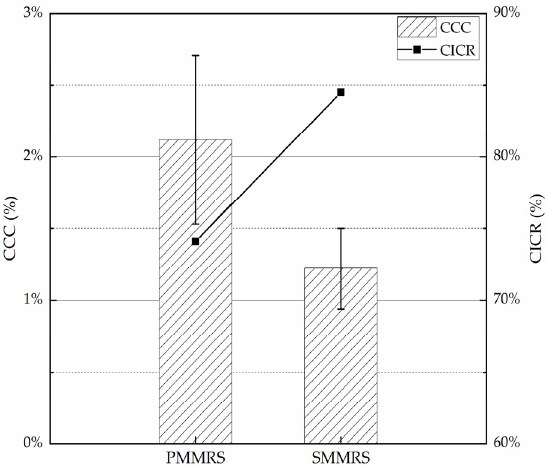
Figure 8. The average CCC and CICR of PMMRS and SMMRS. The average CCC of PMMRS was increased by 74% more than the SMMRS while SMMRS had a higher CICR (Figure 8). Compared to the simple mixing MICP method, pretreatment-mixing MICP method could provide two times calcium ions for mineralized bacteria to generate CaCO 3 theoretically. Therefore, PMMRS could have higher CCC and better mechanical properties. However, excessive calcium ions could also decrease the activity of urease in bacteria solution and attenuates the efficiency for urea hydrolysis. Consequently, PMMRS would have lower CICR